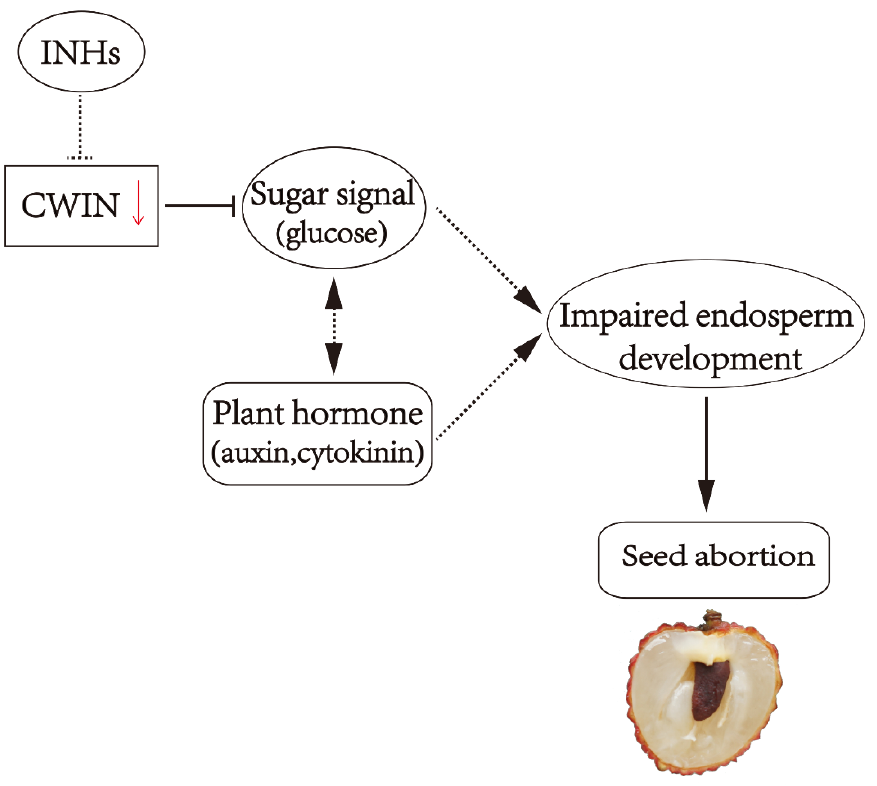
Figure 3. A hypothetic model for CWIN-mediated sugar availability and/or signal in the regulation of seed abortion in NMC.